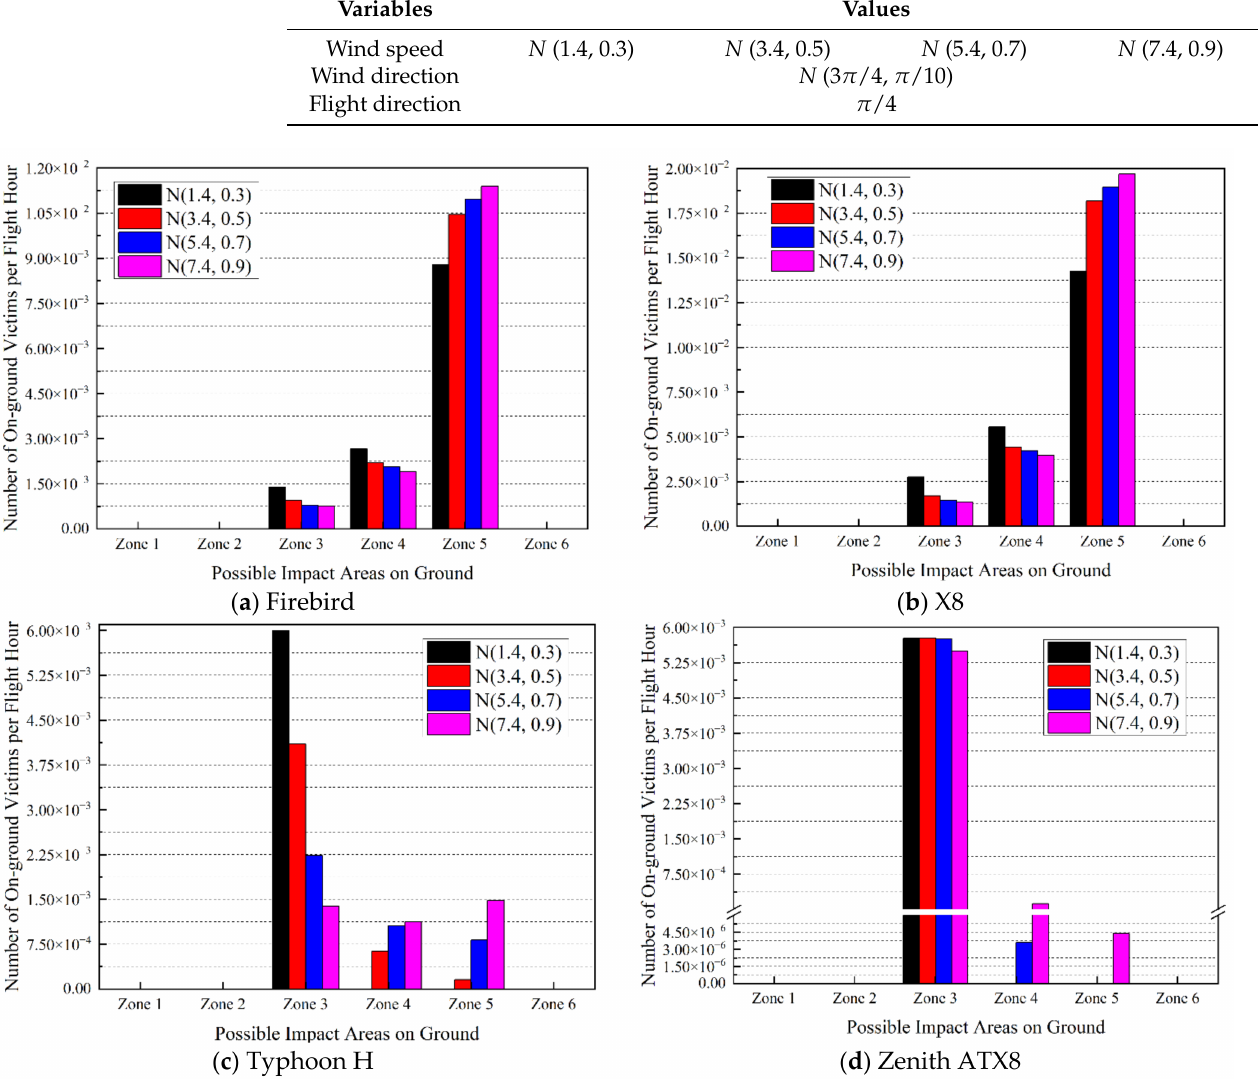
Figure 11. Ground fatalities with different wind